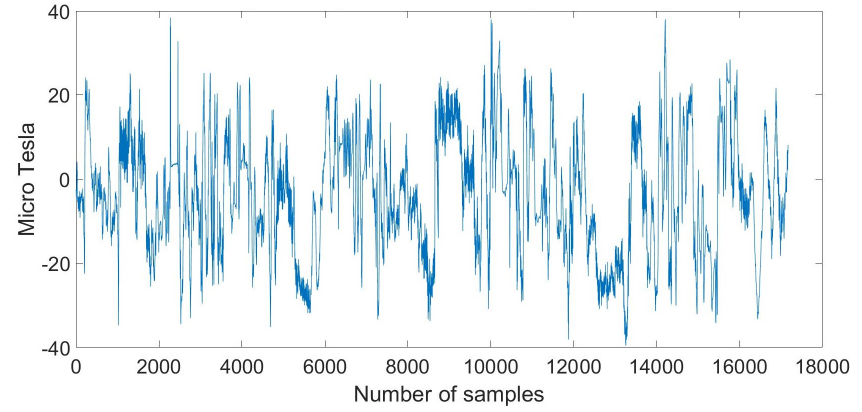
Figure 8. Magnetometer signal from walking into four consecutive buildings.